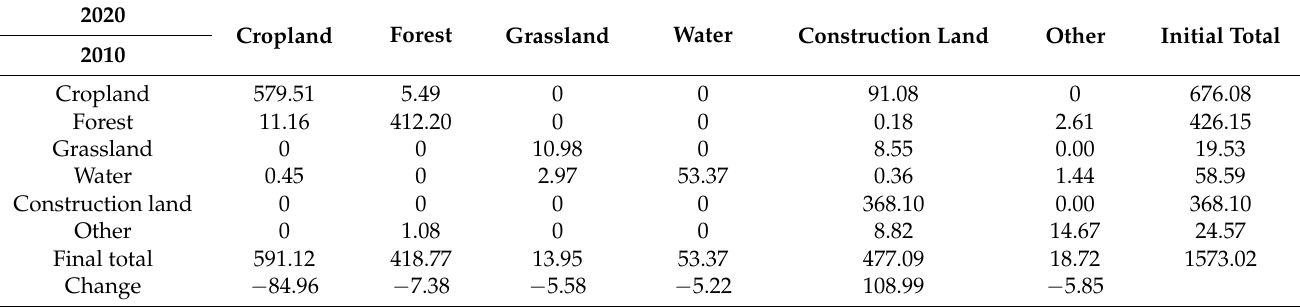
Table 4. Land use conversion in Xiamen from 2010 to 2020 (unit: km 2